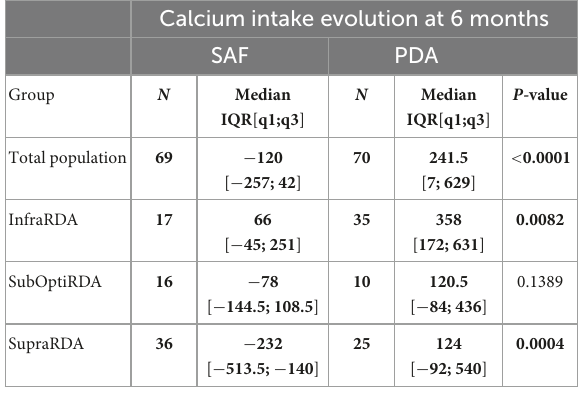
TABLE 3 Daily calcium intake evolution over 6 months in PDA and SAF groups.